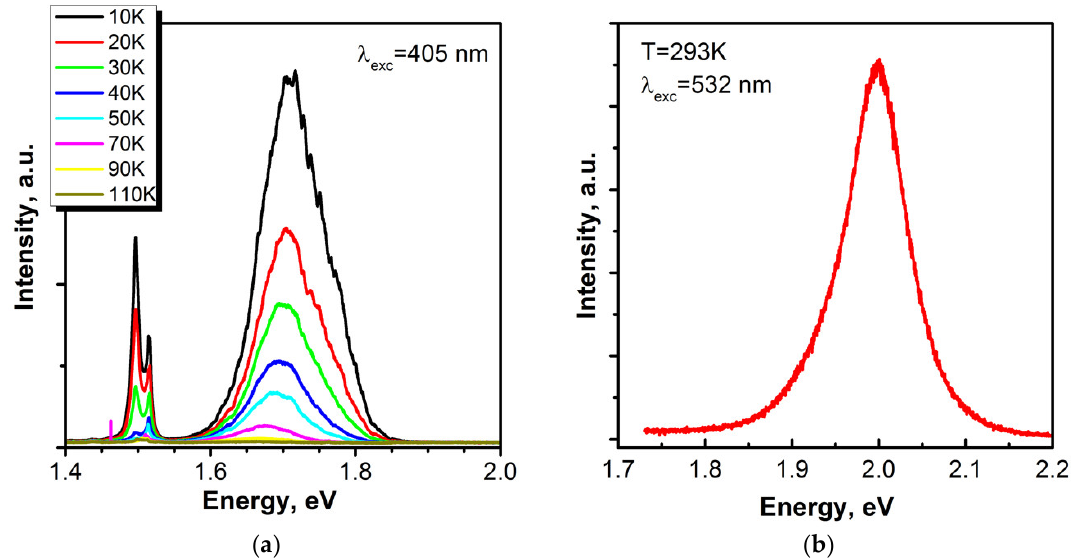
Figure 7. ( a ) μ-PL spectra of the GaSe layer grown at T S = 400 °C as a function of temperature (sample Figure 7. ( a ) µ -PL spectra of the GaSe layer grown at T S = 400 ◦ C as a function of temperature (sample # GS1 ). The laser power density on the sample was below 1 W / cm 2 . ( b ) PL spectrum of the # GS1 ). The laser power density on the sample was below 1 W/cm 2 . ( b ) PL spectrum of the GaSe layer GaSe layer grown at T S = 500 ◦ C (sample #GS7 grown at T S = 500 °C (sample #GS7 ).